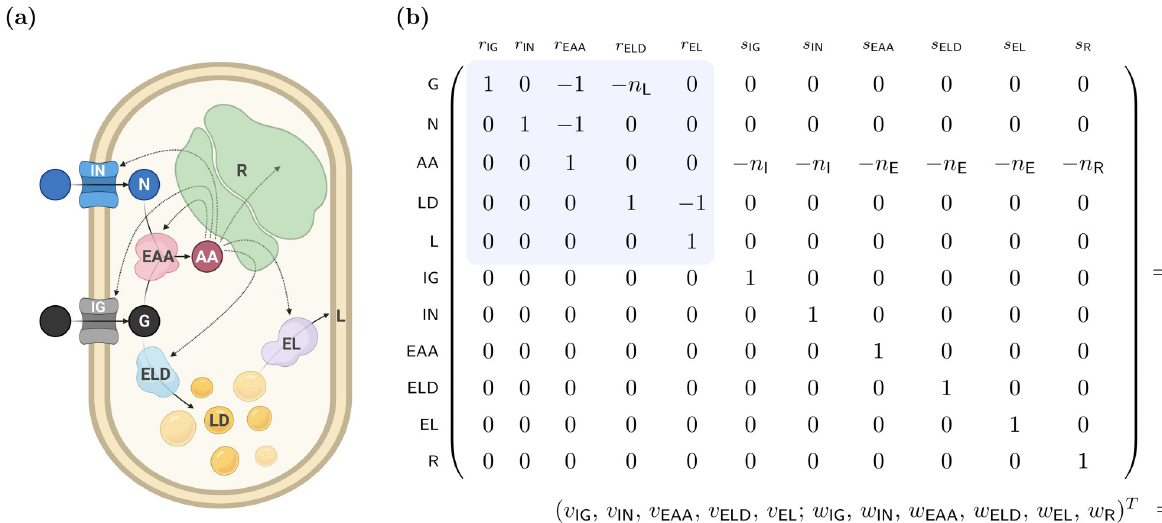
Fig 1. A small model of a self-fabricating cell. (a) The cell has two types of importers, taking up glucose ( G ) and ammonium ( N ) from the environment, and three types of metabolic enzymes, synthesizing amino acids ( AA ) from glucose and ammonium, forming lipid droplets ( LD ) from glucose, and transferring lipids ( L ) to the membrane. Amino acids are used by the ribosome ( R ) to synthesize importers ( IN , IG ), metabolic enzymes ( EAA , ELD , EL ), and the ribosome itself. (b) The resulting stoichiometric matrix and the corresponding flux vector. (Thereby v is used for import and enzymatic reactions and w for synthesis reactions.) In traditional stoichiometric models, only the metabolic part of the stochiometric matrix (shaded in blue) is considered (together with a “biomass reaction”); see also Section